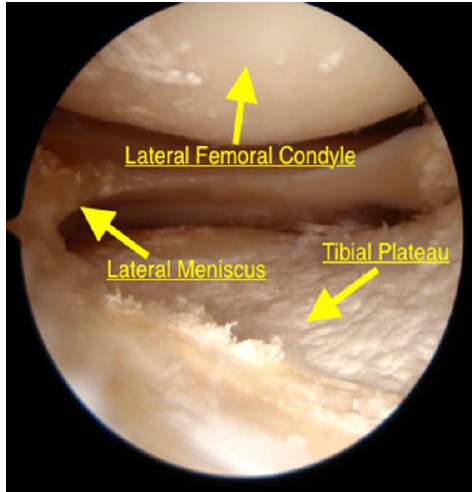
Figure 2. Arthroscopy appearance of the lateral compartment of the knee from the antero-lateral portal. The knee is in the figure-four position to allow adequate visualization of the lateral joint space. The lateral condyle was intact. Crystal deposits are evident in the articular cartilage.